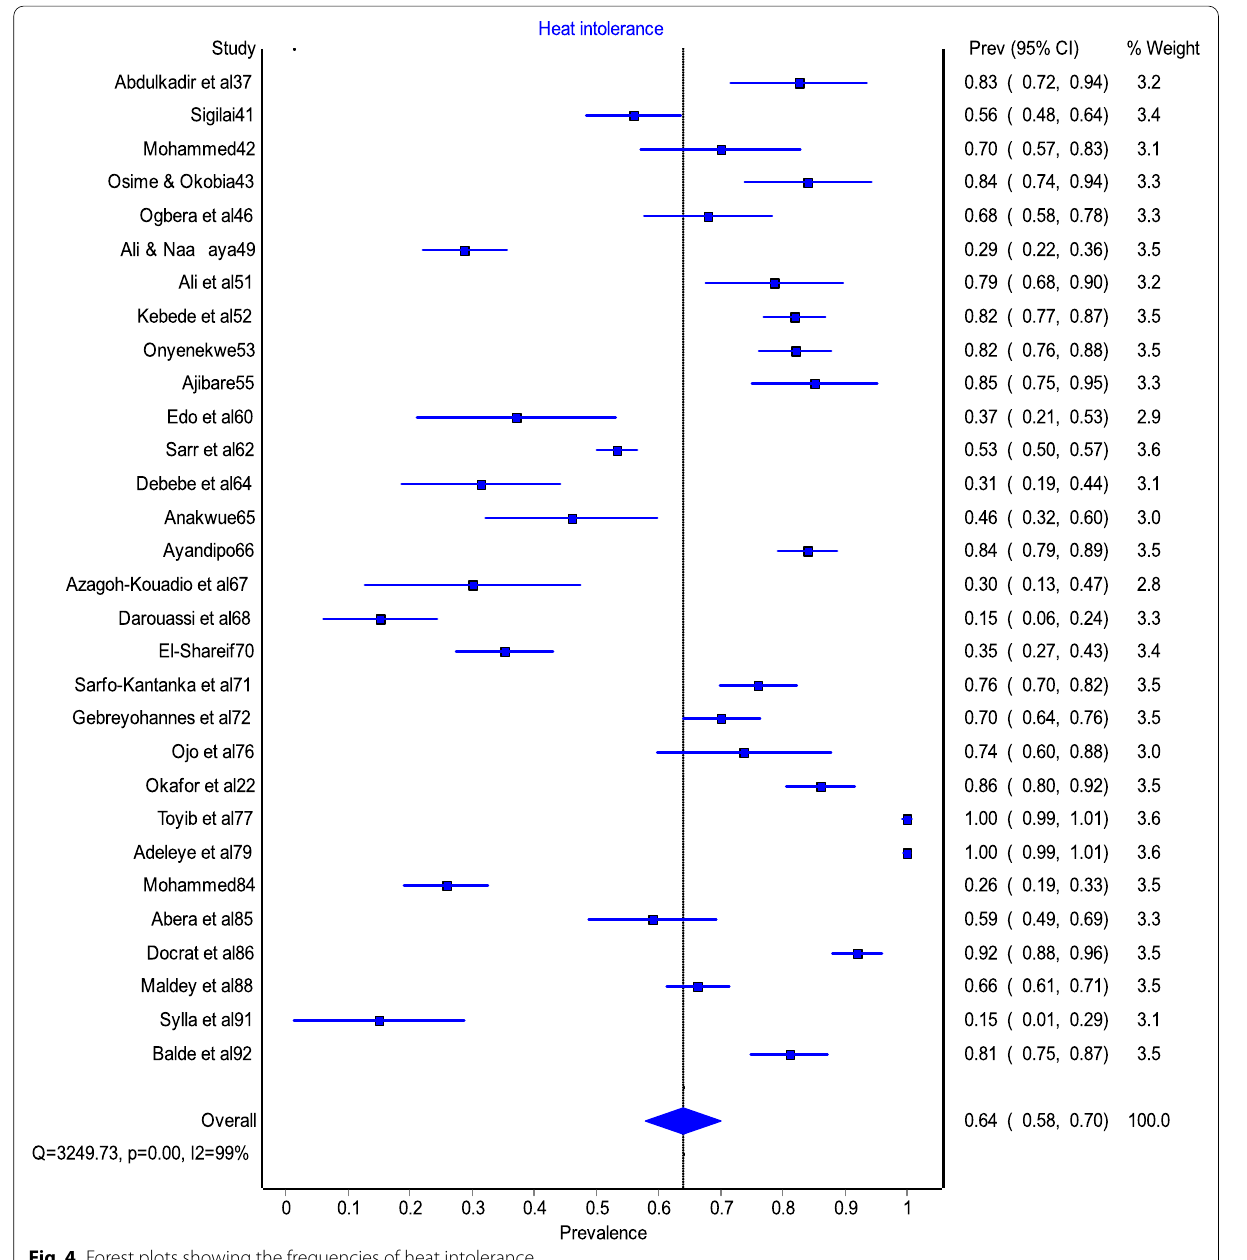
Fig. 4 Forest plots showing the frequencies of heat